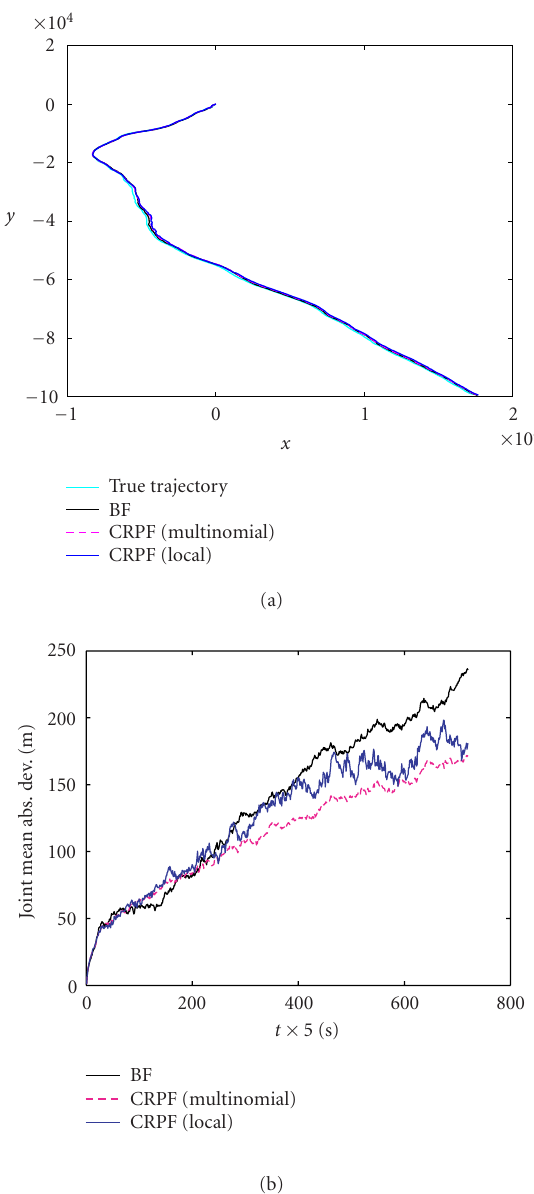
Figure 6: Mixture Gaussian system and observation noise— Gaussian BF. T s = 5 seconds. (a) Trajectory. (b) Mean absolute de- viation.